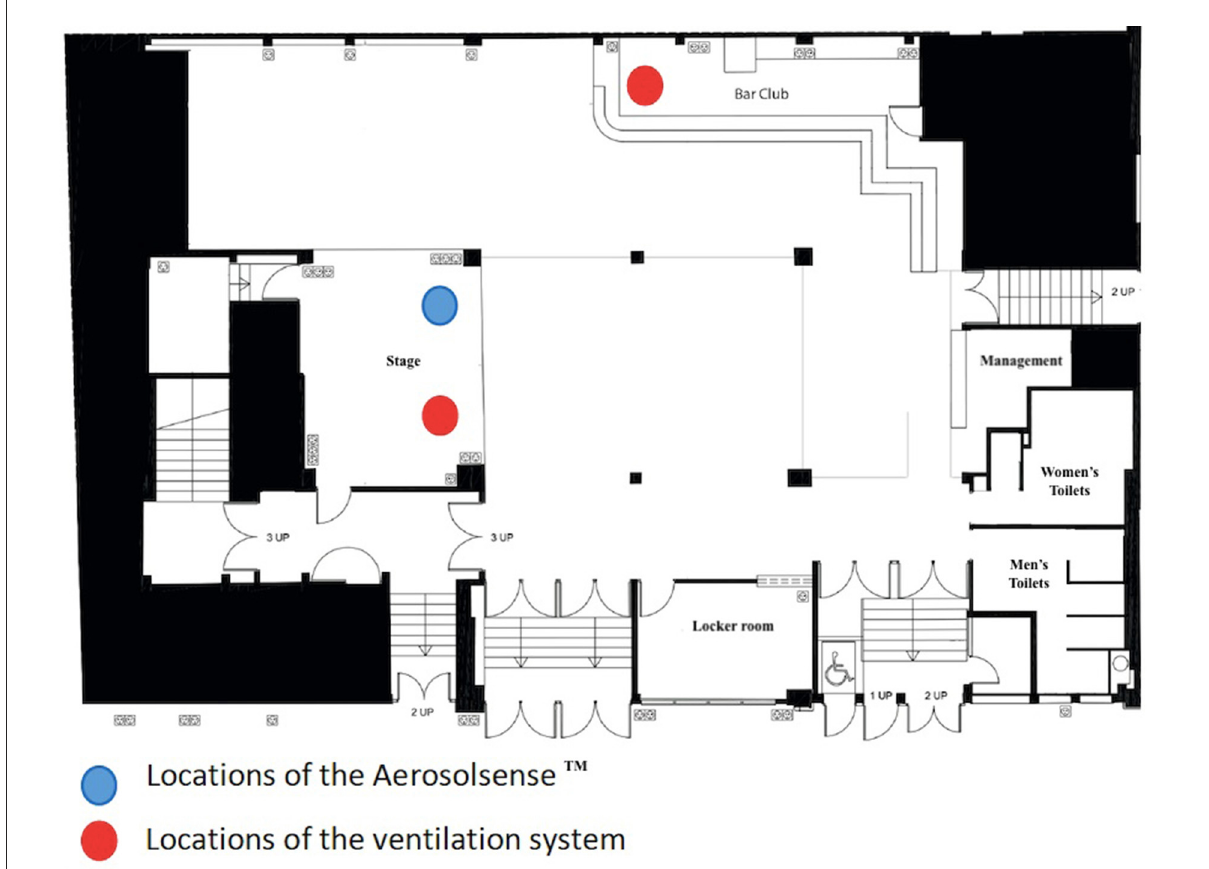
FIGURE2 Plan of the room “La Bellevilloise” and locations of the AerosolSense TM and